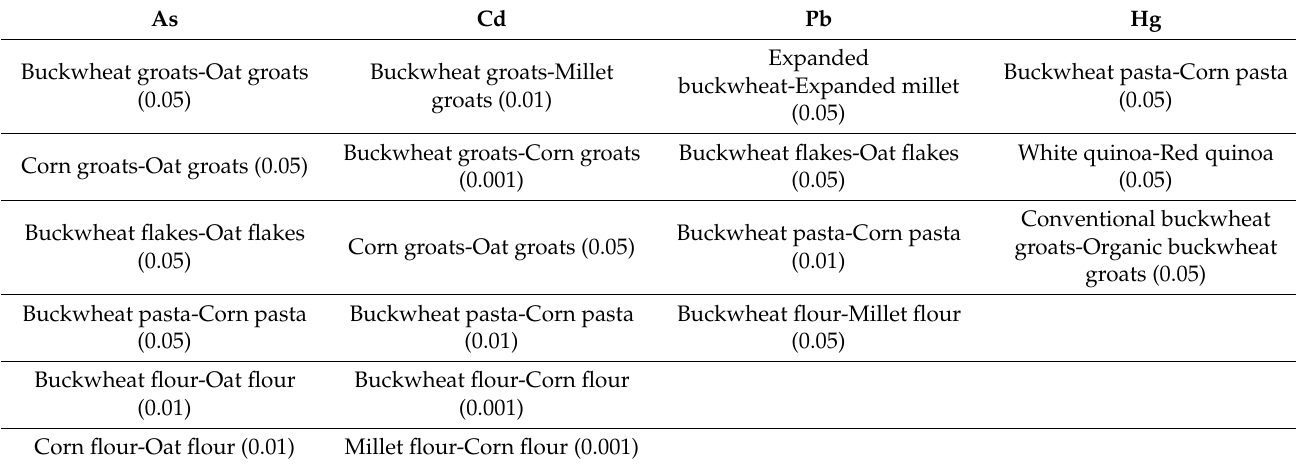
Table 8. Statistically significant differences between the subgroups of products